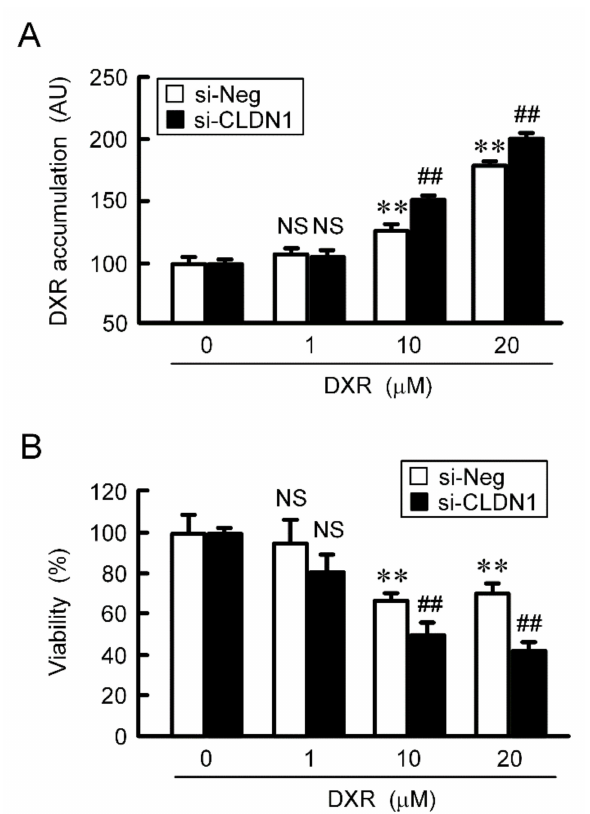
Figure 8. Reduction of chemoresistance by CLDN1 siRNA in 3D culture. A549 cells cultured on PrimeSurface96U multi-well plates were transfected with negative (si-Neg) or CLDN1 siRNA (si-CLDN1). Then, the cells were incubated in the presence and absence of DXR for 60 min ( A ) or 24 h ( B ) at the concentration indicated. The fluorescence intensity of DXR is represented as arbitrary units (AU). Cell viability is represented relative to the values in 0 µ M DXR. n = 4–6. ** p < 0.01 compared with 0 µ M. ## p < 0.01 compared with si-Neg. NS, p >